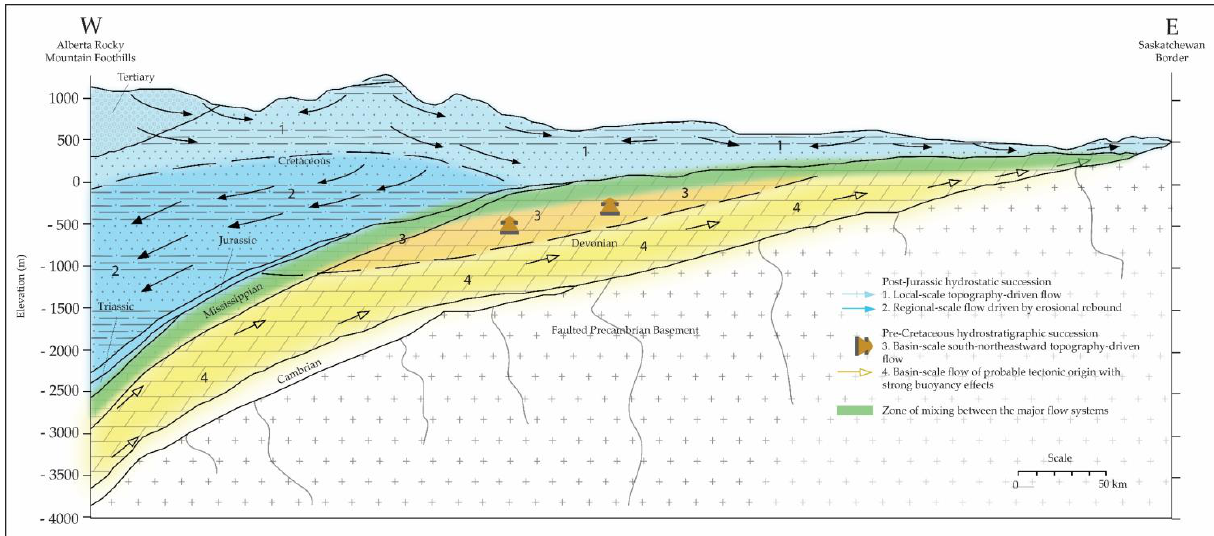
Figure 13. Illustration of the two mega-hydrodynamic regimes in the Alberta Basin. Adapted from Bachu, 1995. © AAPG Bulletin 1995 and reprinted by permission from the AAPG whose consent is required for further use.